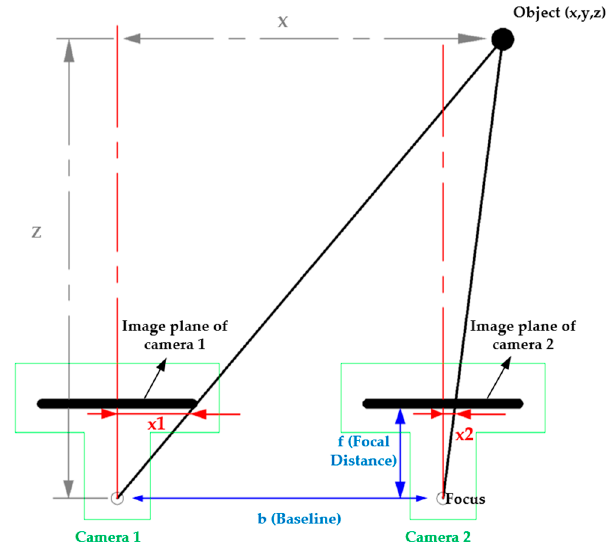
Figure 1. Binocular stereo vision principle. x 1 and x 2 is value of image coordinate and can be obtained from image plane directly, and camera calibration can get f (focal distance) and b (baseline). The z (deep of object) can be calculated by triangle similarity principle, which result as z = f and y can be calculated by z and image plane coordinate.